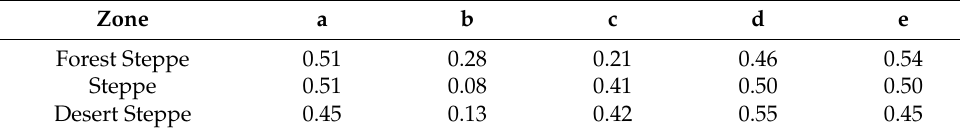
Table 1. Coefficients of proposed VDI model using the PCA method. Zone a b c